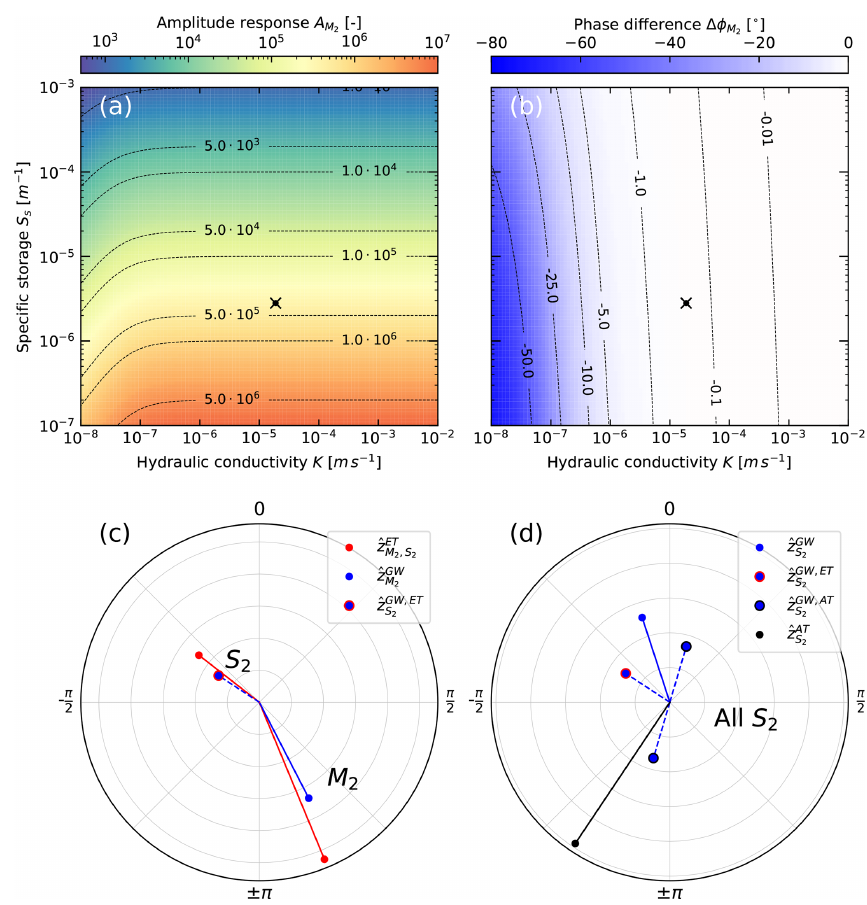
Figure 5. Example amplitude (a) and phase (b) responses calculated for borehole Thirlmere 2 (black dots) using the confined Earth tide model (Sect. 2.2.3). The polar plots show the amplitude and phases of the complex inference of the well response to Earth tides from the response at M 2 (c) , and the disentanglement of the well response at atmospheric tide S 2 (d)